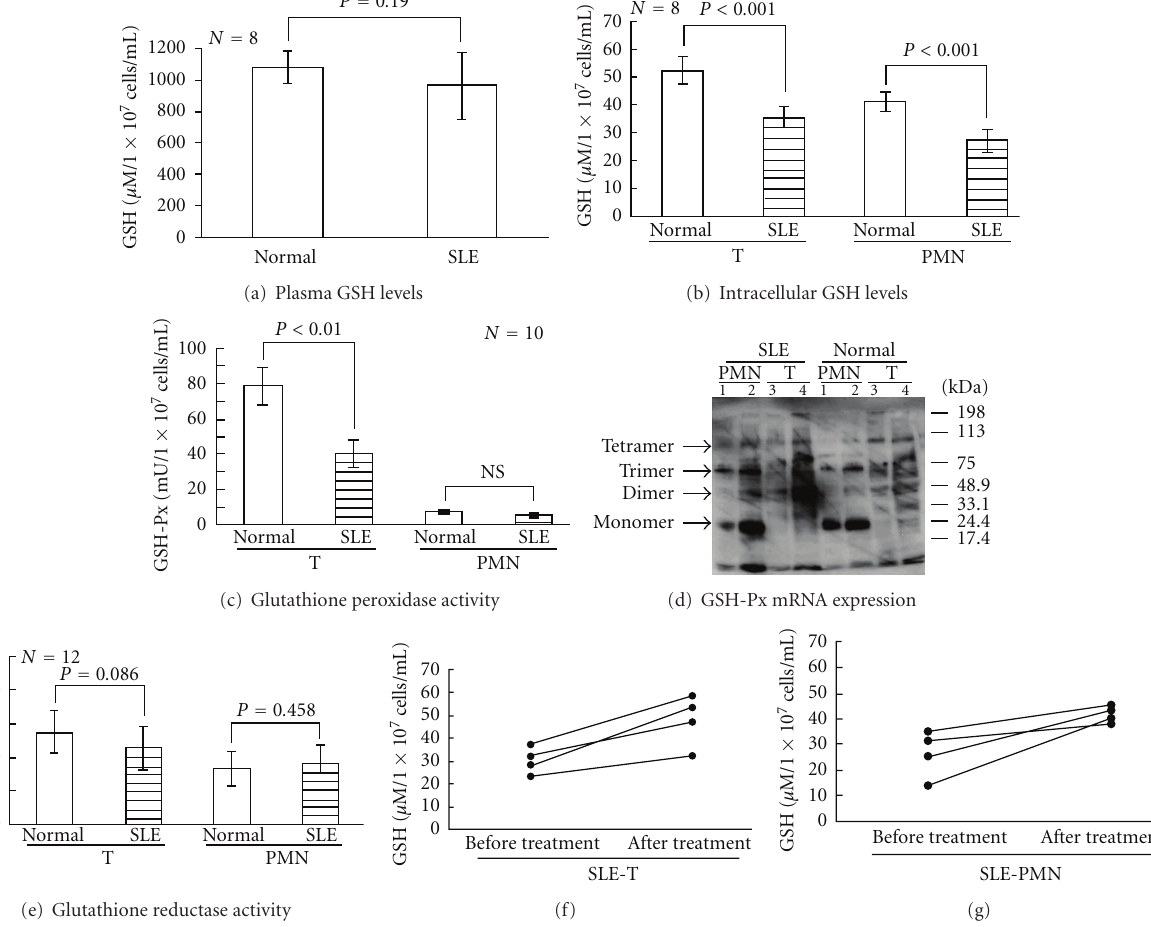
Figure 5: Comparison of plasma and intracellular GSH levels, glutathione peroxidase (GSH-Px) enzyme activity, GSH-Px isomer expression, and glutathione reductase (GSSG-R) enzyme activity in T and PMN from normal and active SLE groups. (a) Plasma GSH levels. (b) Intracellular GSH levels ( μ M/1 × 10 7 cells/mL) in T and PMN of normal and SLE patients. (c) GSH-Px (mU/1 × 10 7 cells/mL) enzyme activity in T and PMN of normal and active SLE group. One milliunit (mU) of GSH-Px enzyme activity is the activity that catalyzes the reduction of 1nmol NADP + /mL/min. (d) Western blot analysis of GSH-Px isomer distribution in two cases of T and PMN from 2 normal and 2 SLE patients. Both normal PMN and SLE-PMN contain mainly monomer (25kDa) and trimer (75 kDa) isomers rather than dimer (50kDa) and tetramer (100 kDa) isomers. In contrast, dimer (50kDa) and tetramer (100kDa) isomers were the main isomers found in normal and SLE-T cells. Lanes 1 and 2 are di ff erent cases of PMN. Lanes 3 and 4 are di ff erent cases of T. (e) Comparison of GSSG-R enzyme activity in T and PMN of normal and SLE group members. (f) Intracellular GSH levels in active SLE-T before and after e ff ective treatment. (g) Intracellular GSH levels in active SLE-PMN before and after e ff ective